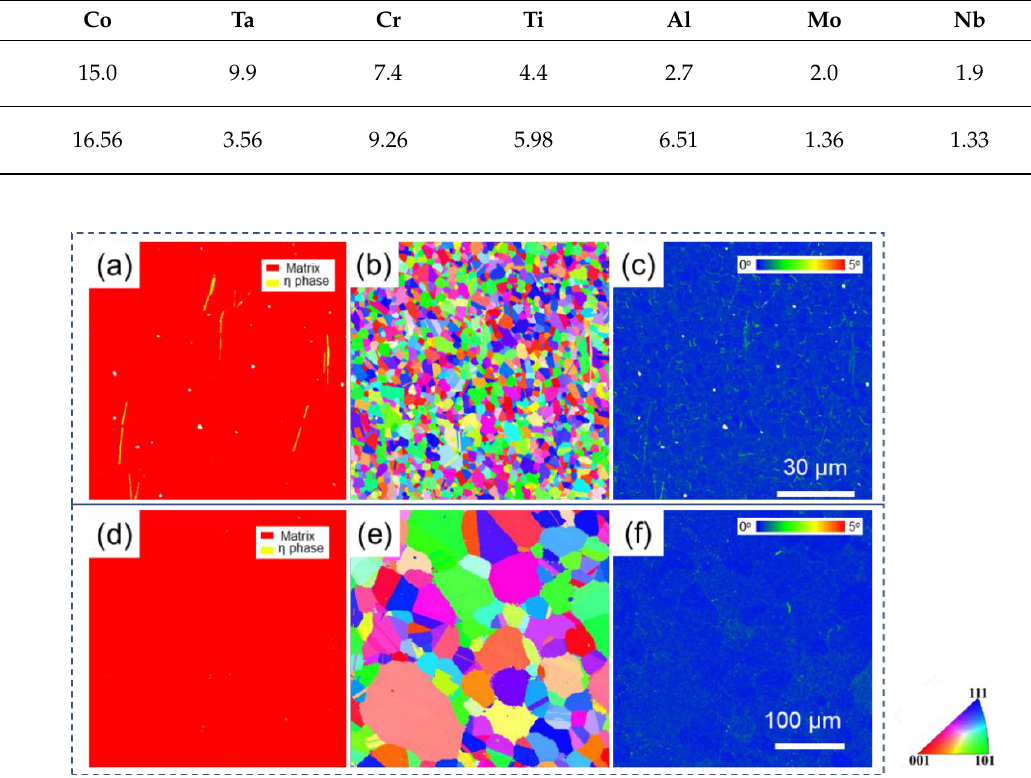
Figure 3. Phase map ( a , d ), Inverse pole figure ( b , e ), Kernel Average Misorientation map ( c , f ), for undeformed SL ( a – c ) and SH ( d – f